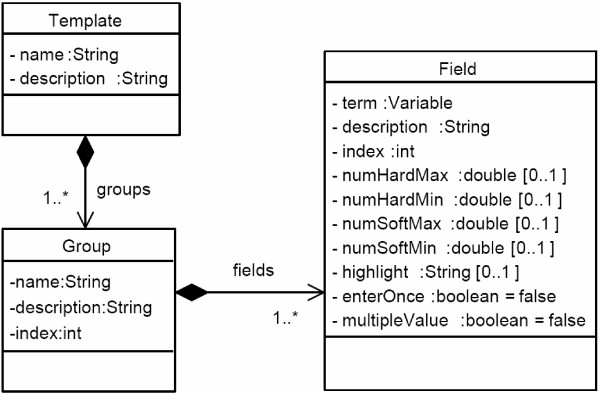
TDS UML Class Diagram.